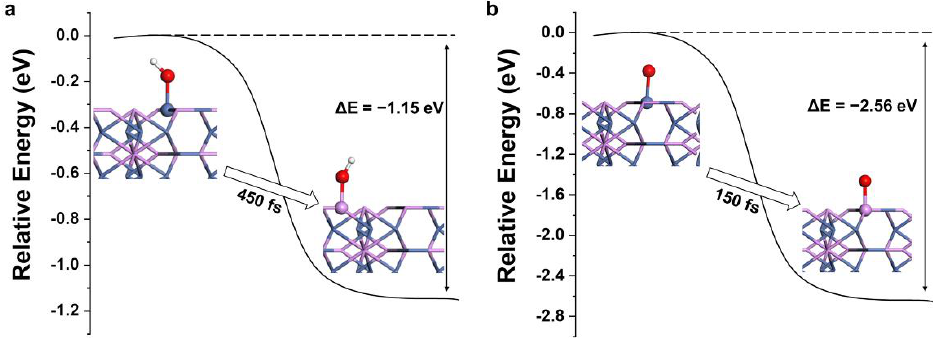
Figure 3. Relative energy distributions for different products on Ni 12 P 5 (001) surface: ( a ) Ni*OH → P*OH ( b ) Ni*O → P*O. The white, red, purple, and blue spheres represent H, O, P, and Ni, respectively.